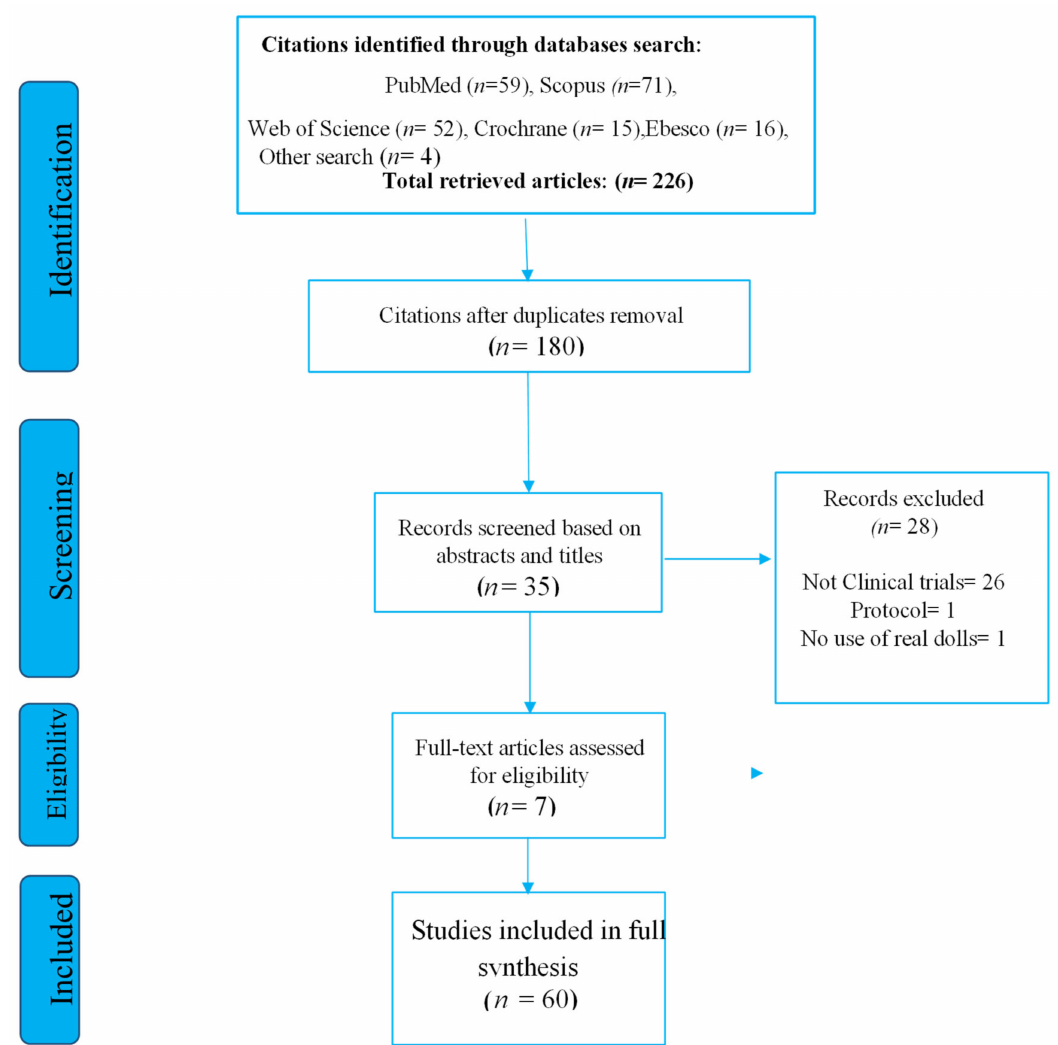
Figure 1. The PRISMA diagram for the records search and study